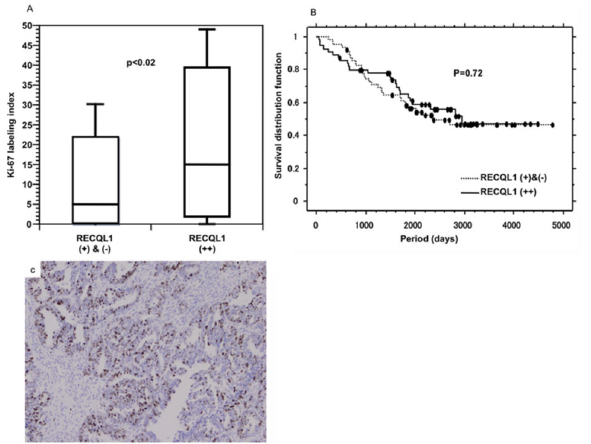
Figure 2. Tumor cell proliferation index and survival estimate. (A) Correlation between Ki-67 labeling index and RECQL1 (++) cases. Photomicrograph illustrates high Ki-67 staining in the serous adenocarcinoma. RECQL1 (++) cases were significantly associated with high Ki-67LI (p=0.02). (B) Kaplan-Meier survival estimate between RECQL1 (++) and (+), (-) cases. By log-rank analysis, there was no significance between RECQL1 expression and overall survival (p=0.72). doi: Figure 1. Histological features and RECQL1. (++) expression in ovarian cancers. KOC-2S, KOC-3S, OVCAR-3, OVCAR-5, KOC-7C, SK-OV-3 and TOV-112D cell lines. Interestingly, TOV-21G and MCAS Mucinous showed a similar low expression to the normal TIG-3 cell line. adenocarcinoma and (E) intact ovarian stroma as negative control (inset: hematoxylin and eosin staining).